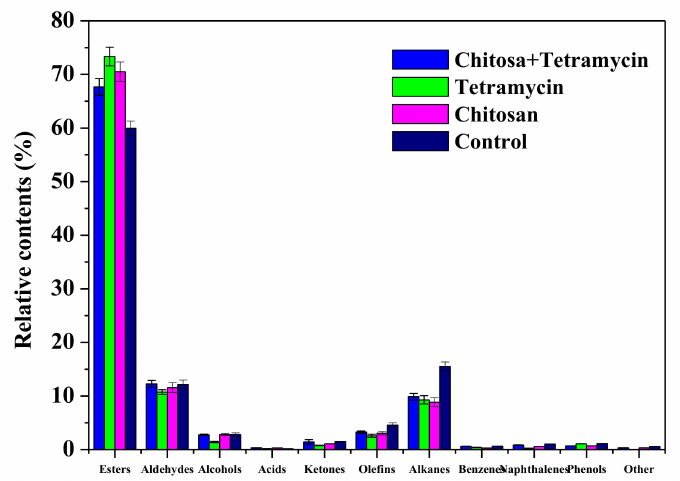
Figure 2. The effects of chitosan and tetramycin on the aromatic compound species of kiwifruit. Values and error bars indicate the mean and SD of three replicates,